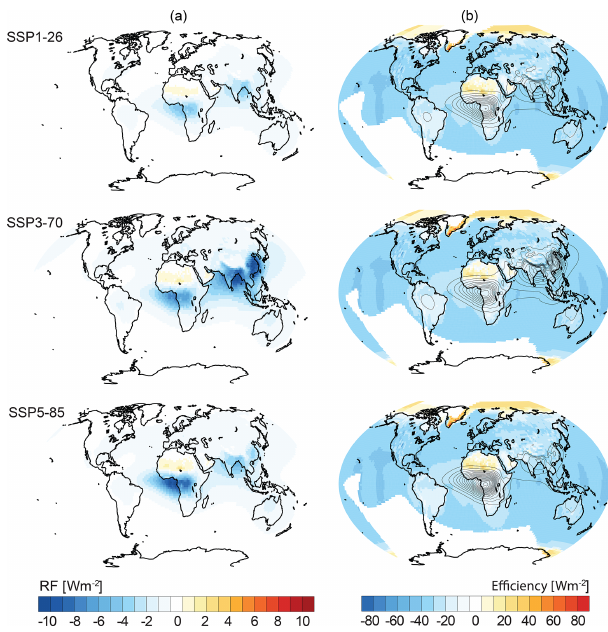
Figure 7. Clear-sky RF and efficiency for the mid-2090s. Shown are the (a) SW TOA instantaneous radiative forcing and (b) forcing ef- ficiency as RF divided by τ . Contours show τ at 550nm from 0.04 in steps of 0.04 (compare Fig. A3). All forcings are for clear-sky conditions in the mid-2090s from selected CMIP6 emission scenar-